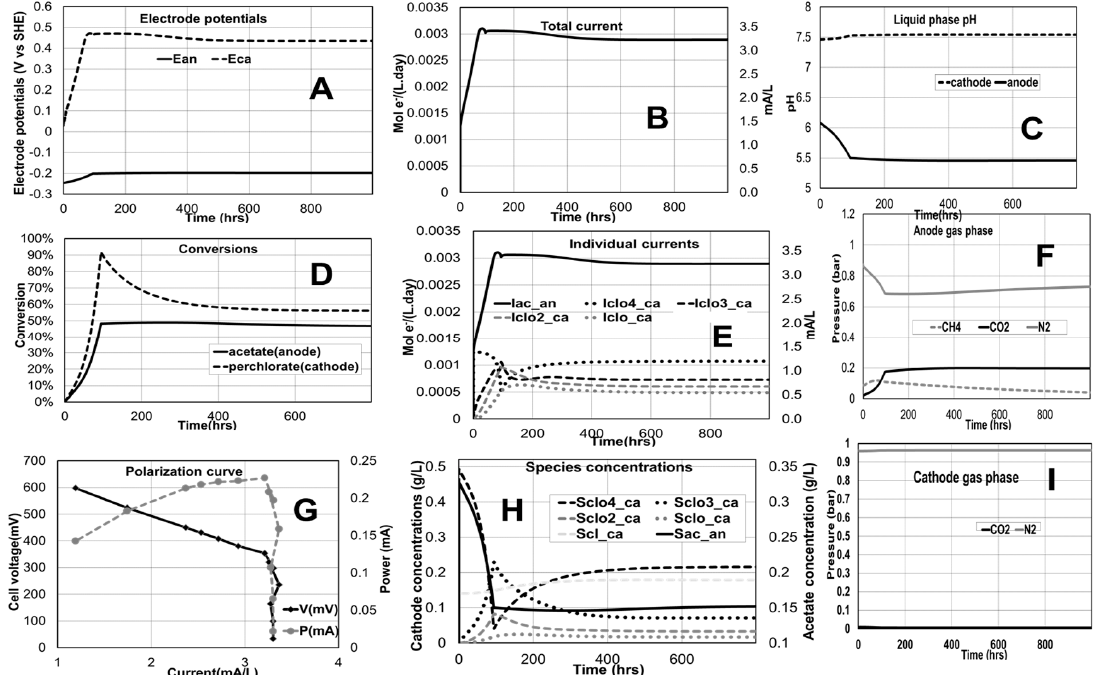
Figure 3. Time evolution of variables of interest for perchlorate remediation base case simulation (Anode: inlet flow rate − 300 mL/day, acetate concentration − 350 mg/L, volume − 200 mL; Cathode: inlet flow rate − 300 mL/day, perchlorate concentration − 350 mg/L, volume − 200 mL; proton exchange membrane used; external resistance is 419.01 ohms). ( A ) Anode and cathode potentials; ( B ) Total current; ( C ) pH in anode and cathode compartments; ( D ) Conversions of chemical species ( E ) Individual current contributions; ( F ) Anode gas phase composition; ( G ) Polarization curve; ( H ) Concentrations of the different chemical species; ( I ) Cathode gas phase composition.